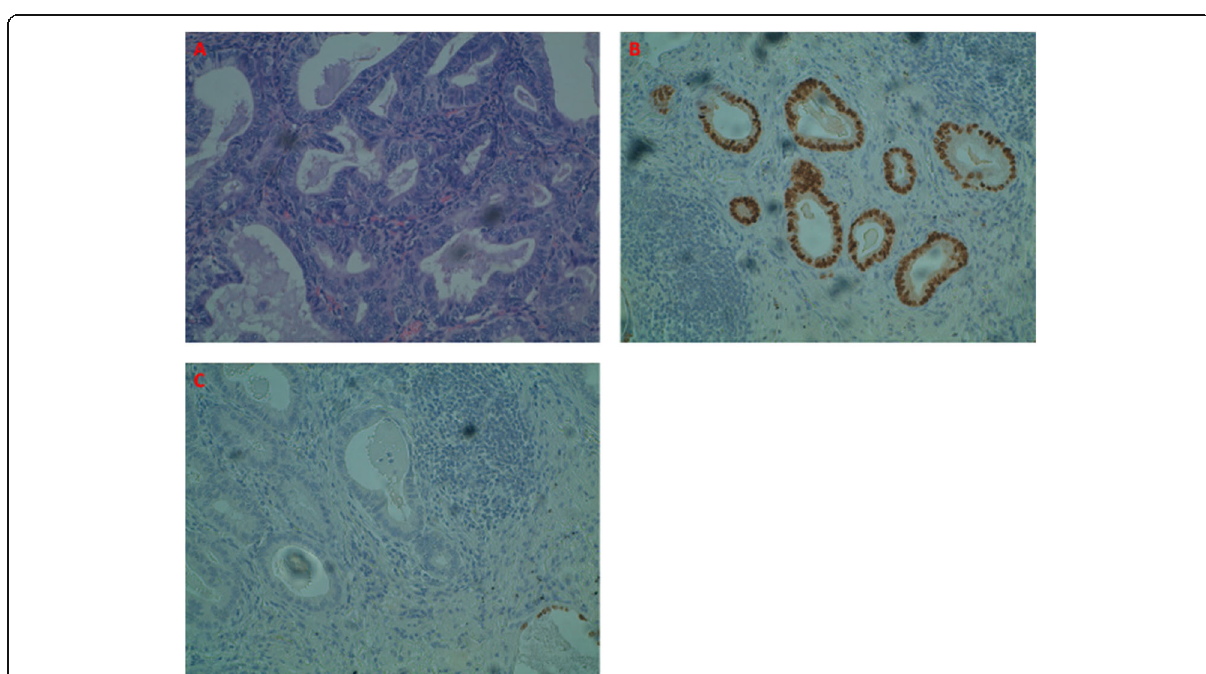
Fig. 2 Histological examination of right lung lobectomy, showing tumoral cells colored with hematoxylin-eosin ( a ), positivity for estrogen receptor (ER) ( b ), and negativity for thyroid transcription factor 1 (TTF-1) ( c )